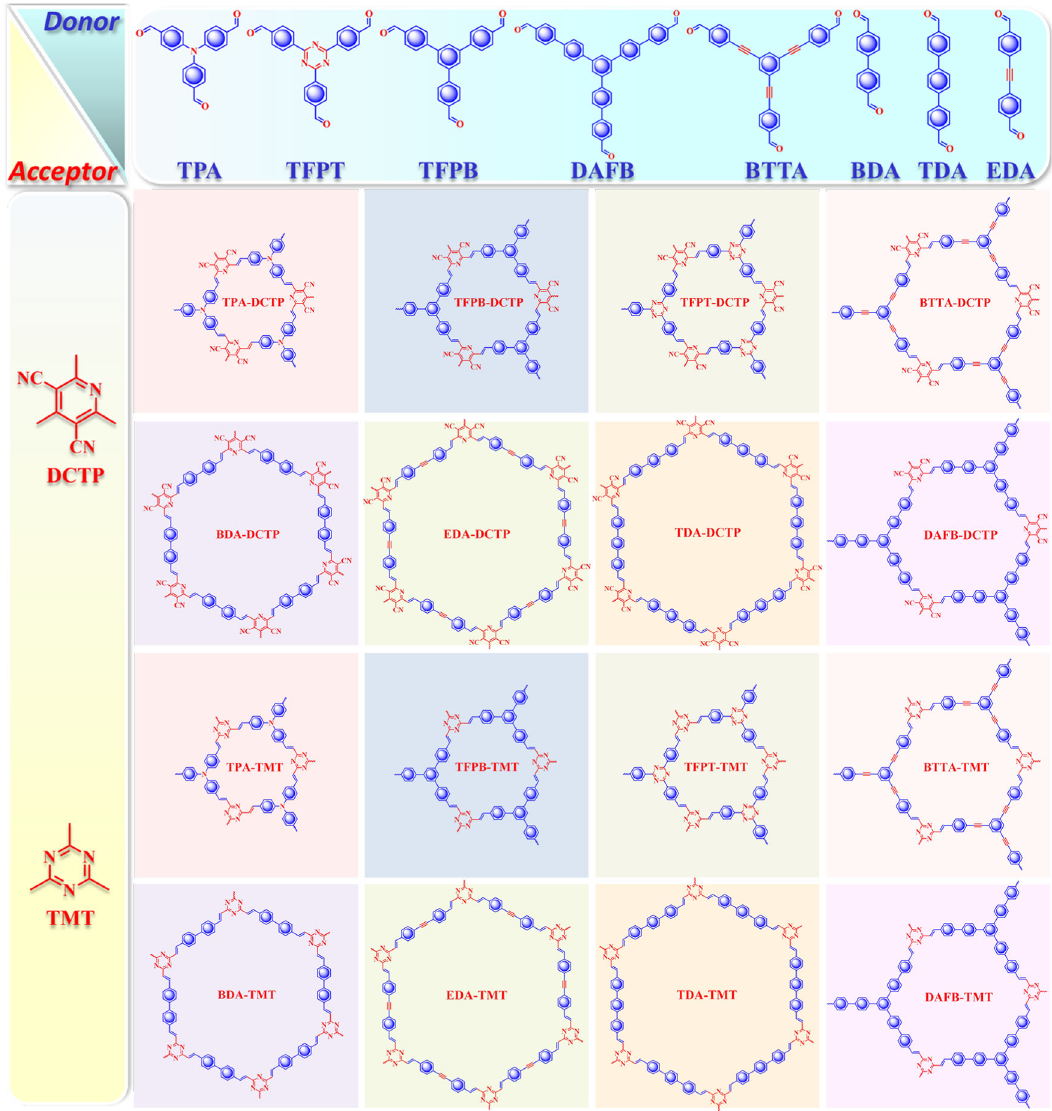
Fig. 2 Chemical structures of synthesized COFs. Using two electron-de fi cient monomers as key receptors and eight electron-rich monomers as donors, 16 ole fi n-linked donor-acceptor COFs were